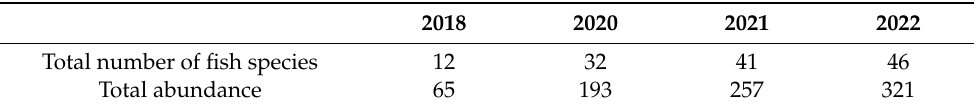
Table 3. Total number of species and individual fish observed in the Coral Greenhouse from 2018 to 2022.